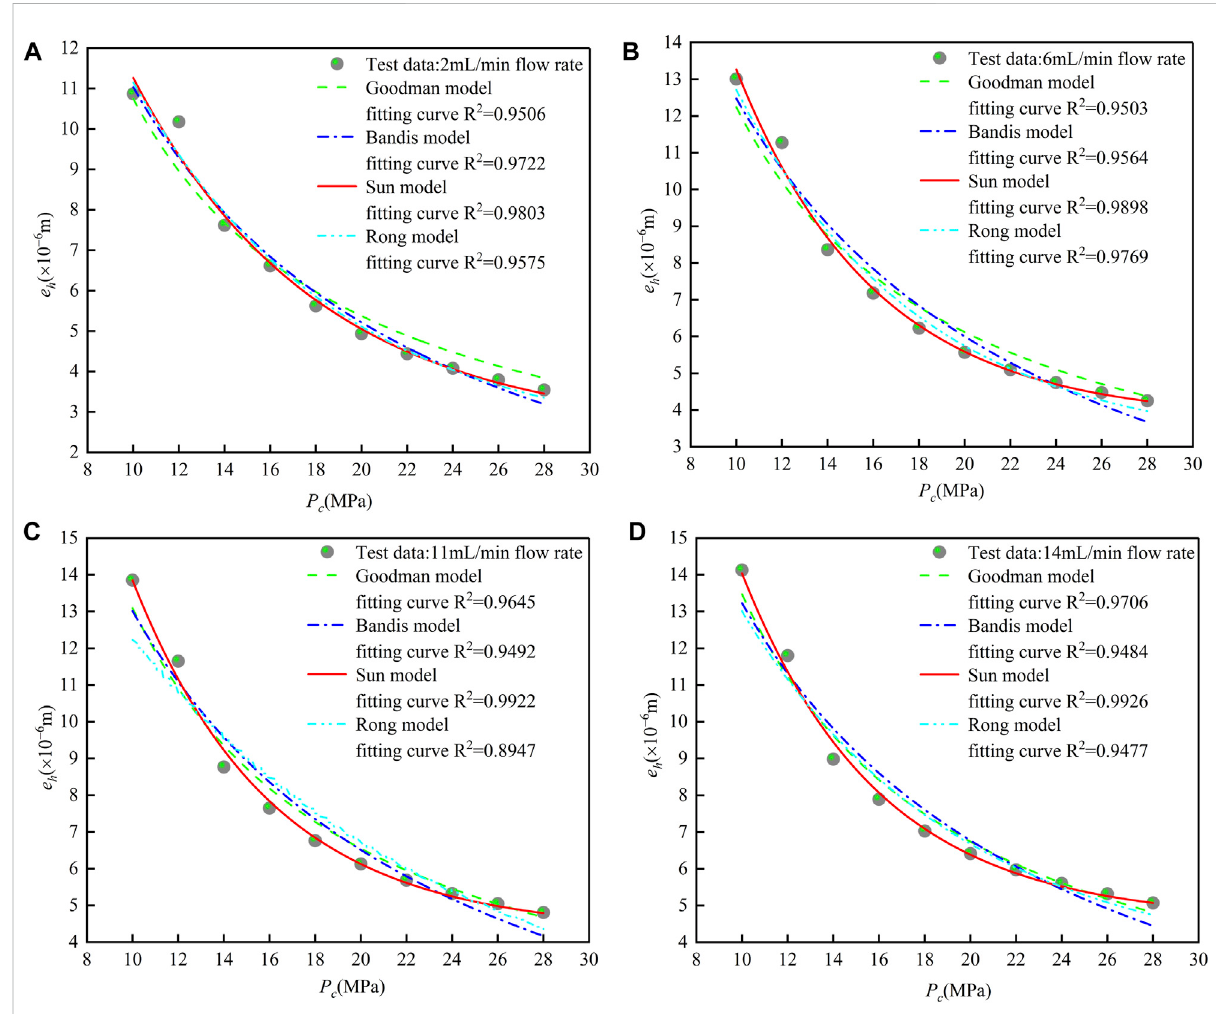
FIGURE 3 Variations in the hydraulic aperture ( e h ) with increasing con fi ning pressure ( P c ). (A) Shale sample with a single fracture, Q =2 ml/min. (B) Shale samplewithasinglefracture, Q =6 ml/min. (C) Shalesamplewithasinglefracture, Q =11 ml/min. (D) Shalesamplewithasinglefracture, Q =14 ml/ min. The solid line is the fi tting curve for the Sun model, the dashed line is the fi tting curve for the Goodman model, the dotted-dashed line is the fi tting curve for the Bandis model, and the dashed-dotted-dotted line is the fi tting curve for the Rong model. The discrete symbols are measurement points from the hydromechanical tests with different fl ow